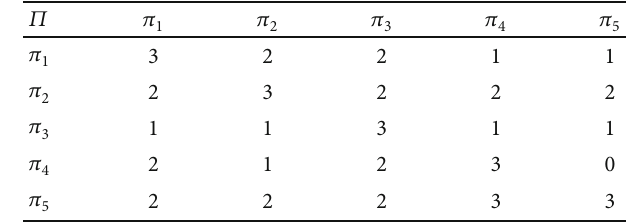
Table 3: The third positive pole membership intervals.